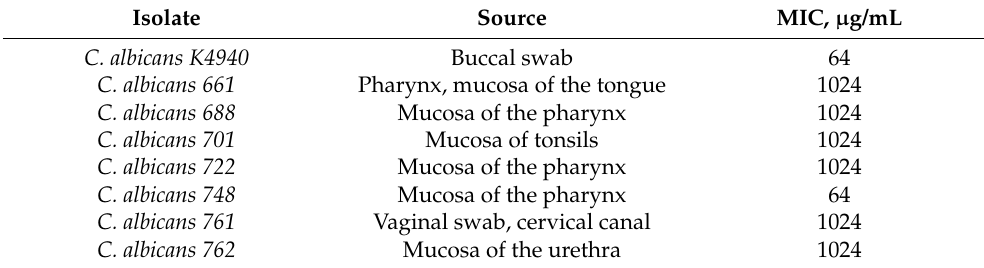
Table 1. Source of C. albicans clinical isolates and their susceptibility to fluconazole.